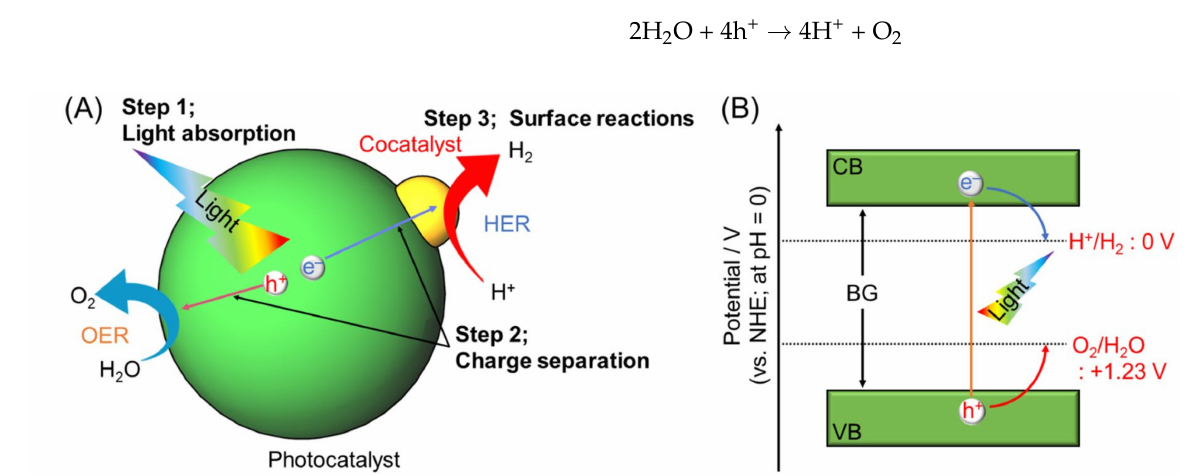
Figure 3. ( A ) Schematic of photocatalytic water-splitting reactions: Step 1, light absorption; Step 2, charge separation; and Step 3, surface reactions. ( B ) Principle of water splitting using semiconductor photocatalysts. HER, OER, VB CB, and BG represent hydrogen evolution reaction, oxygen evolution reaction, valence band, conduction band, and band gap,